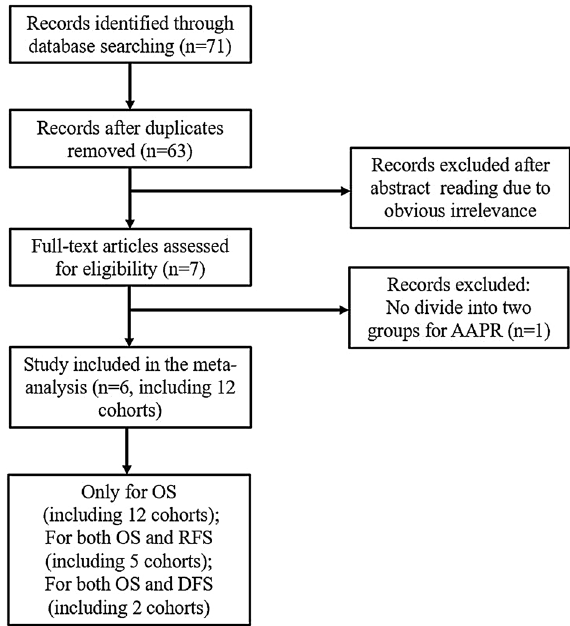
Figure 1. Flow diagram of the study selection procedure.